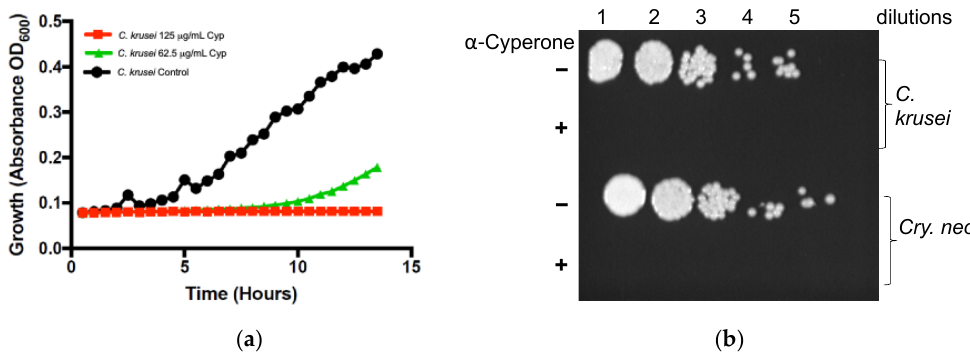
Figure 2. Antifungal activity of α -Cyperone against Candida and Cryptococcus species. ( a ) C. krusei was grown in honeycomb microtiter wells containing RPMI 1640 medium in the presence (62.5 µ g/mL & 125 µ g/mL) and absence of α -Cyperone for about 14 h at 37 ◦ C. Fungus growth was measured by absorbance at optical density (OD) 600 nm using Bioscreen-C growth monitor. ( b ) Control ( − ) and α -Cyperone exposed (+) (MIC dose) fungal cells from microtiter wells were serially diluted and spot tested on YPD agar plates. Plates were incubated at 30 ◦ C for 2-days and photographed. A representative image is shown.